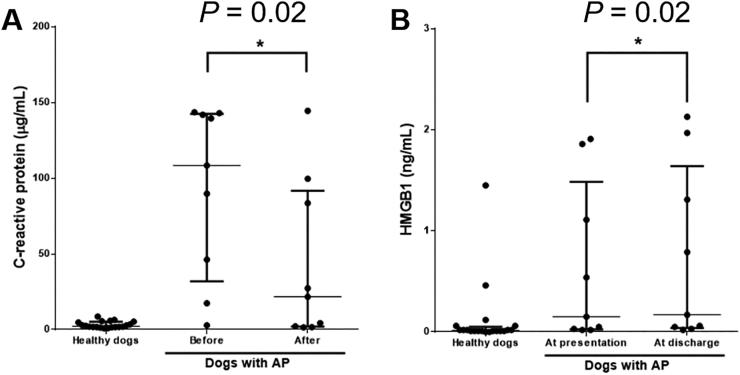
Comparison of serum concentrations of (A) C-reactive protein and (B) HMGB1 before and after treatment in AP dogs with SIRS (n = 9). The horizontal bars indicate the medians and interquartile ranges. *P < 0.05 (Wilcoxon matched-pairs signed rank test). AP, acute pancreatitis; HMGB1, high mobility group box 1; SIRS, systemic inflammatory response syndrome.